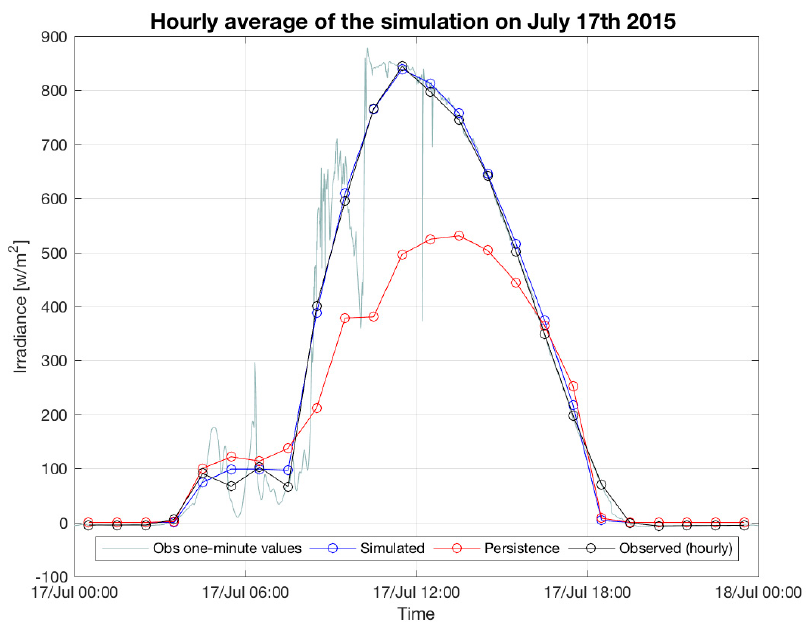
Figure 5. The hourly average of simulation on 17 July 2015 from 05:01 to 18:00. The grey line shows the measured one-minute values.